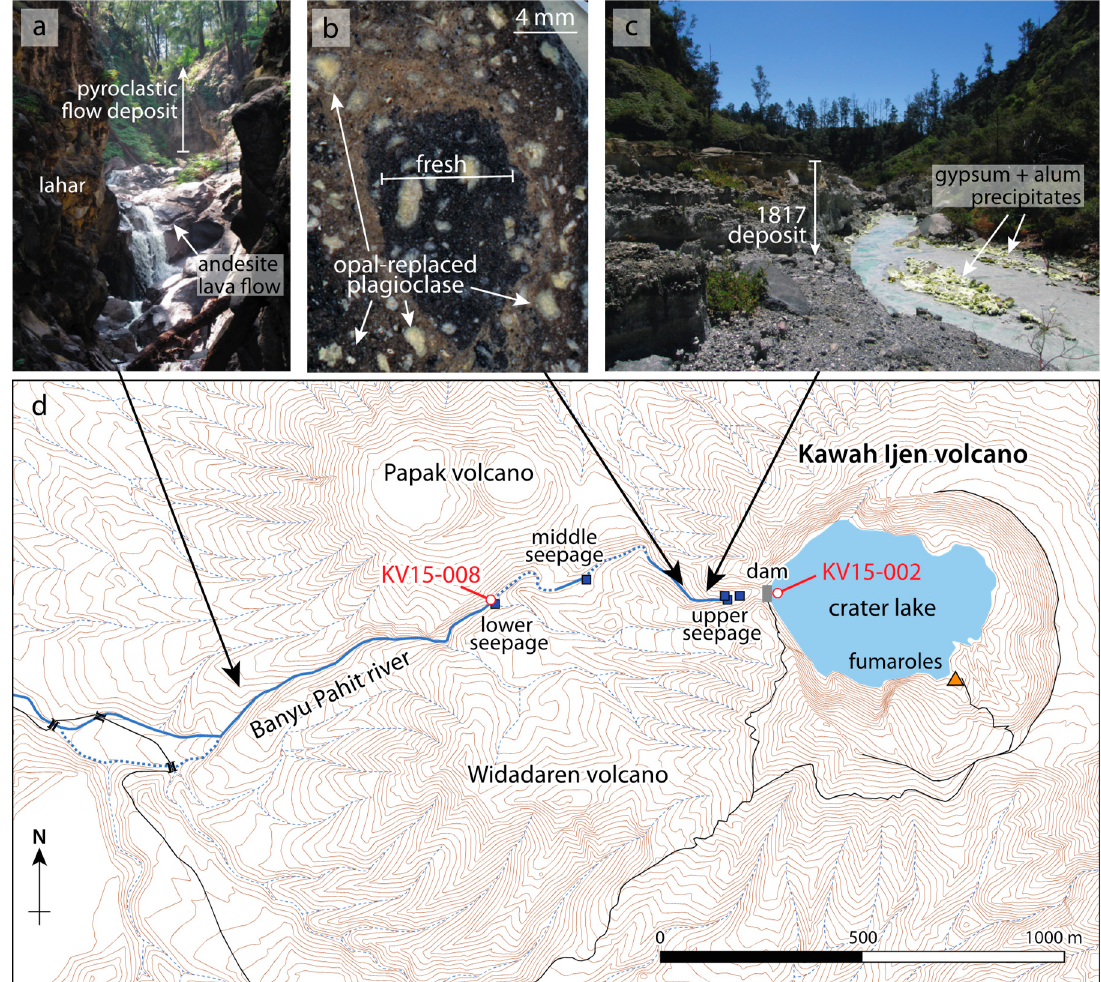
Figure 1. Topographic map of Kawah Ijen volcano and the upstream Banyu Pahit river, showing the locations of acid-water seepage springs and samples used in this study ( d ). The river flows on phreatic and phreato-magmatic deposits in its uppermost valley ( c ) including those from the 1817 eruption, whereas it flows on an andesite lava flow further downstream in a deeply incised steep-sided valley with lahar, pyroclastic flow, mudflow and fall deposits exposed in the valley walls ( a ). 1817 Scoria in contact with the hyperacidic river water alter progressively from the rim of the clast inward ( b ), observed by a change in colour and the progressive replacement of plagioclase by glassy